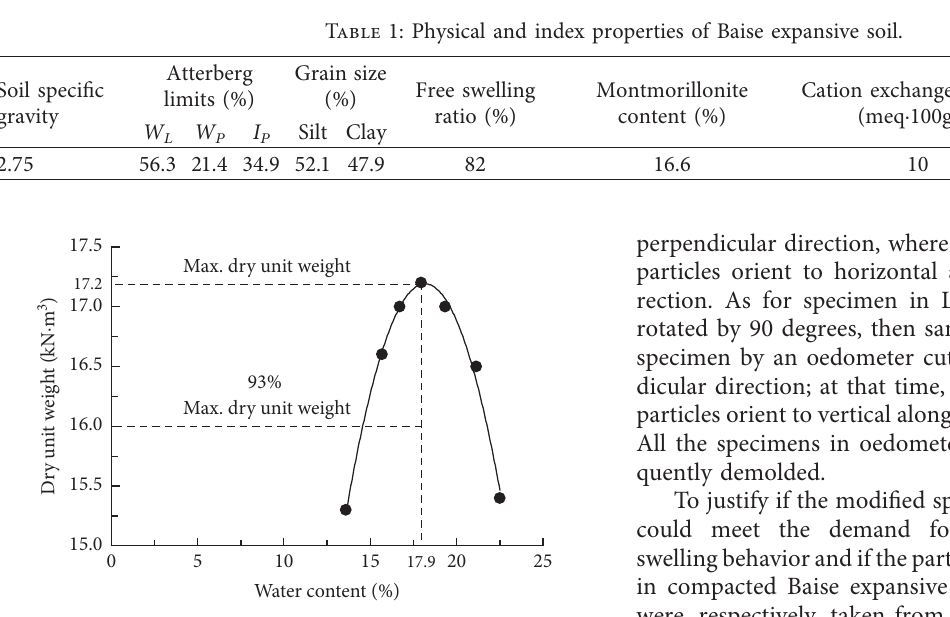
Figure 3: Proctor compaction curve of Baise expansive